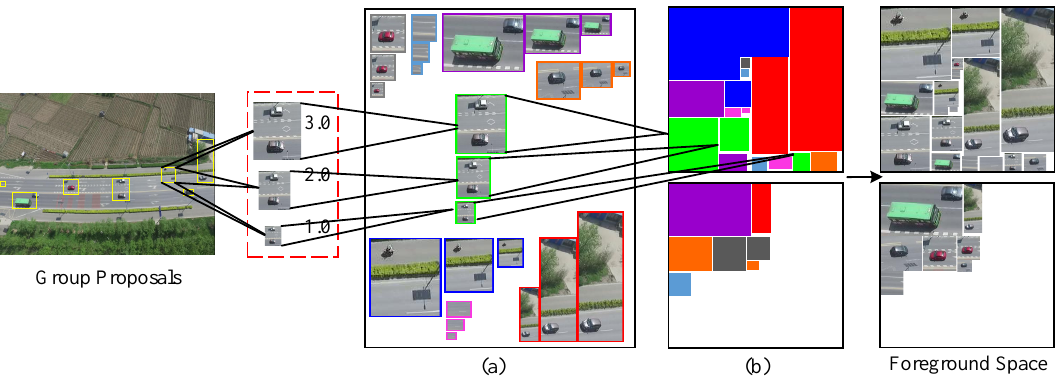
Figure 5. An overview of the visual detail augmented mapping method. This contains two modules: one is ( a ) multi-resolution mapping and the other is ( b ) foreground augmented mapping. Taking the group proposal involving two cars obtained by Section 2.1 as an example, through three scales of multi-resolution, the cars are mapped to normal size with more detailed object information. Then, the second part maps them into a new foreground space in which the original target area is